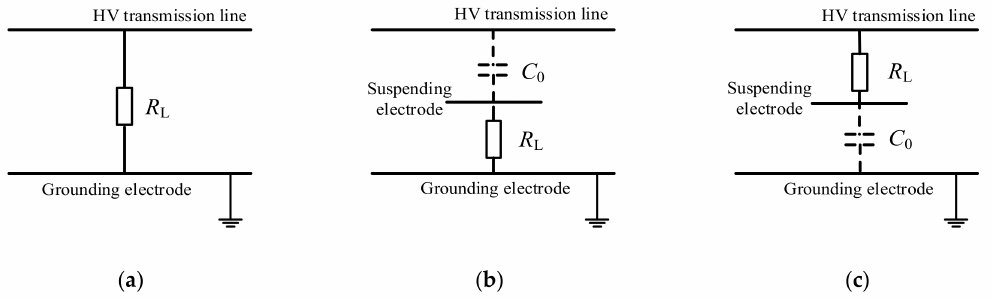
Figure 3. Schematic diagram of energy harvesting under electrostatic field; ( a ) direct-mode EEH; ( b ) low-potential EEH; ( c ) high-potential